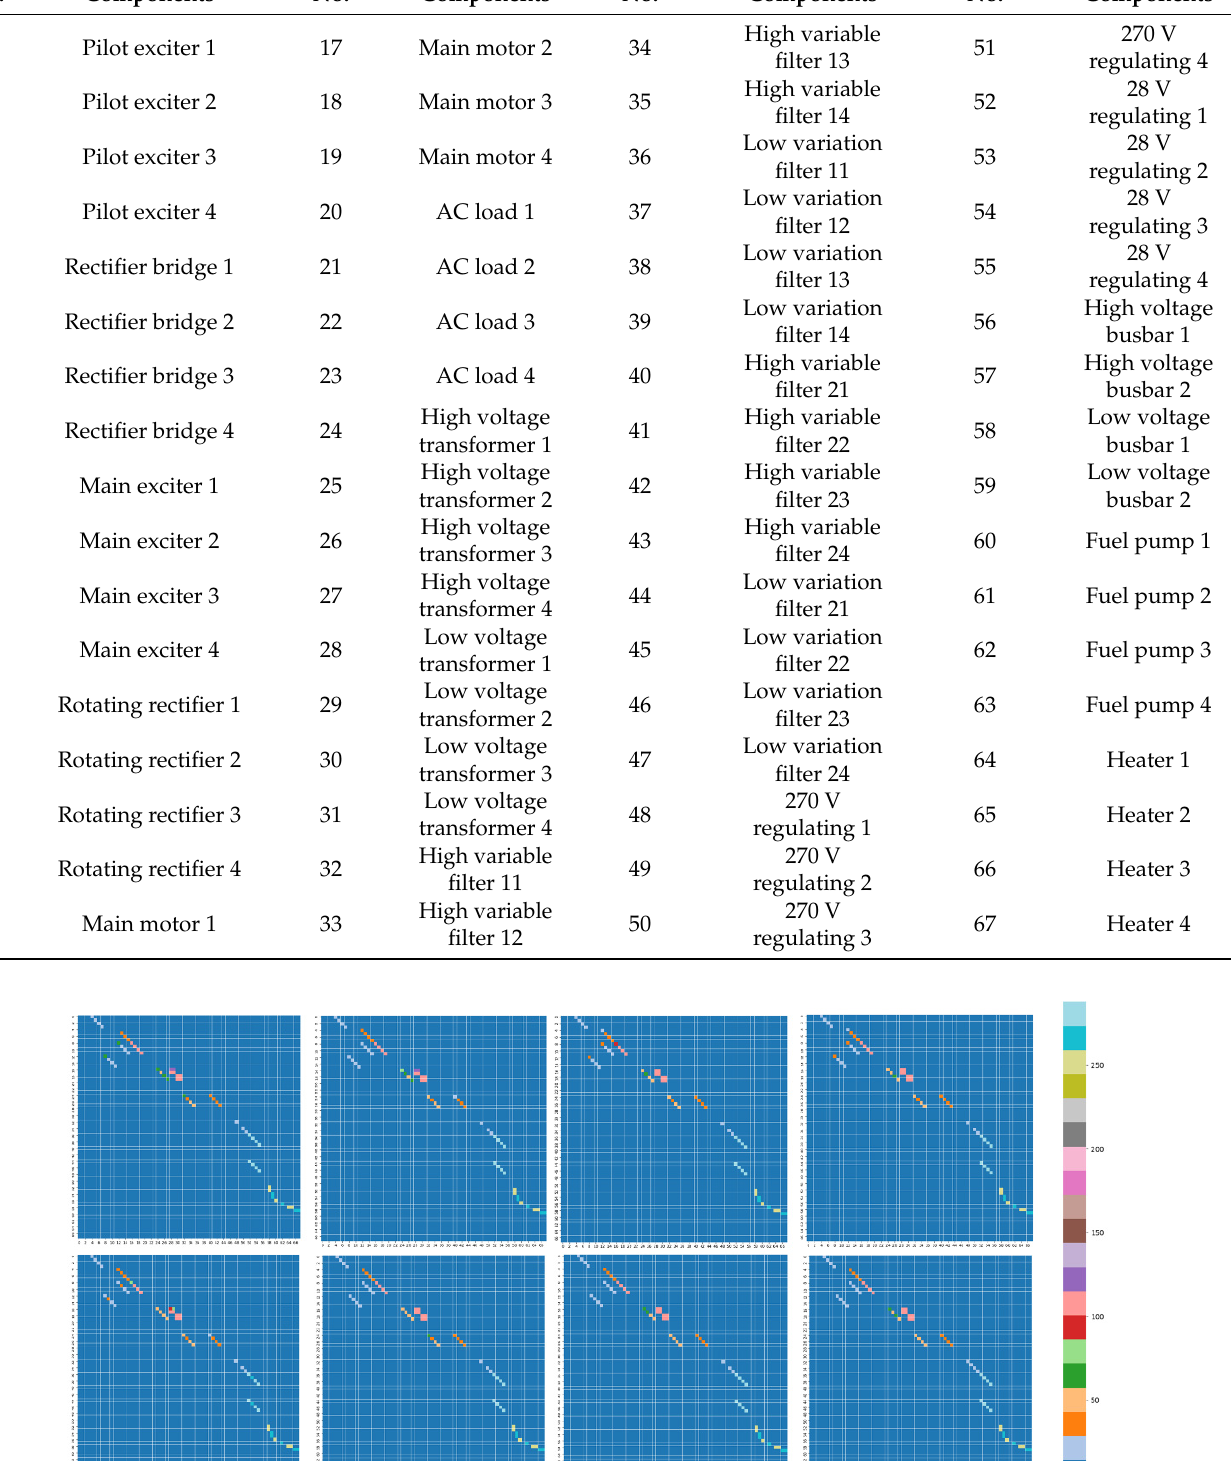
Figure 12. Comparison of associated fault graph. As is shown in Figure 12, the associations of the components highlighted in the two graphs have changed, and the coordinates are (8, 12) and (12, 8), respectively. In the graphs, 4 represents No. 1 main exciter and 12 represents No. 1 rotating rectifier. The change also verified that the armature winding of the exciter has a phase-to-phase short- circuit fault and further verified the rationality and interpretability of the construction of the graphs. Based on this, this study constructs a cluster of typical associated fault modes of the power supply system, organically integrates the structural knowledge of the power sup- ply system, signal propagation direction, and parameter characteristics, and realizes the enhancement of data-based associations. Finally, structured storage is carried out. On the one hand, the associations and signal propagation relationship of each component of the power supply system can be obtained through the graphs, and on the other hand, the characteristics of the components are deeply extracted. The graphs can directly reflect the changes in component associations caused by the change of parameter characteristics un- der different fault conditions, thus saving storage space and providing a basis for improv- ing the efficiency of the diagnosis model.